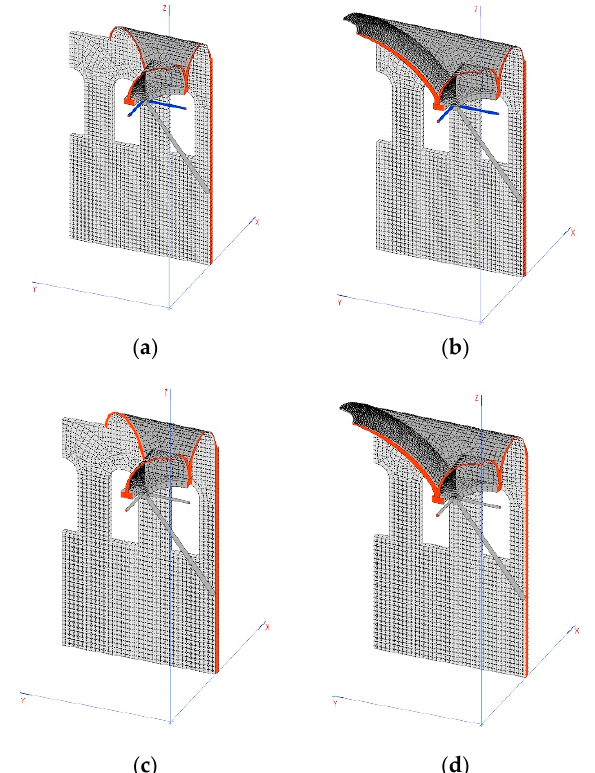
Figure 11. Diagrams of the different phases of construction: ( a ) gallery, ( b ) tension, ( c ) dome, and ( d ) relaxation.